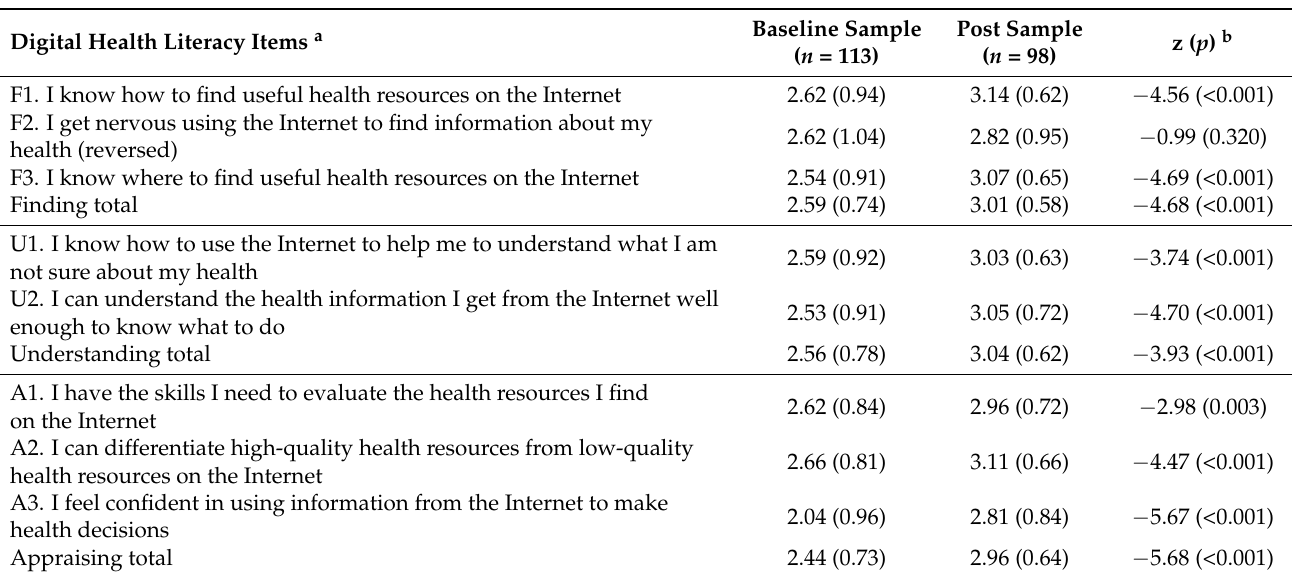
Table 4. Digital Health